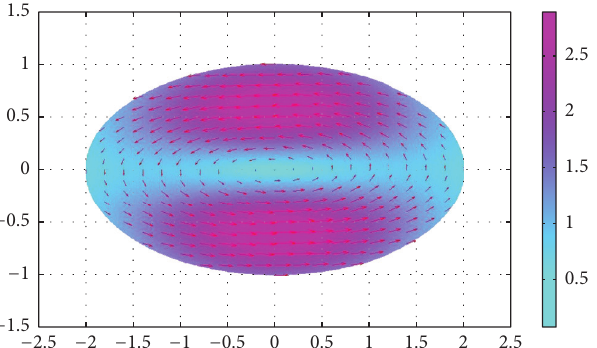
Figure 7: Tangential stress field per unit twist 𝜏 2 /𝛼 ; 𝑎 = 2 , 𝑏 = 1 ; 𝑘